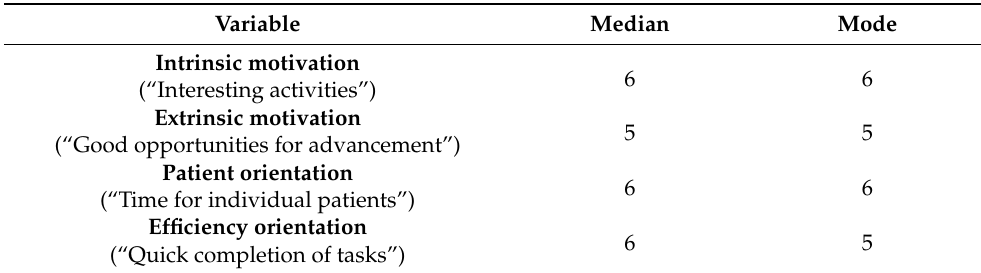
Table 3. Importance of job characteristics for respondents.